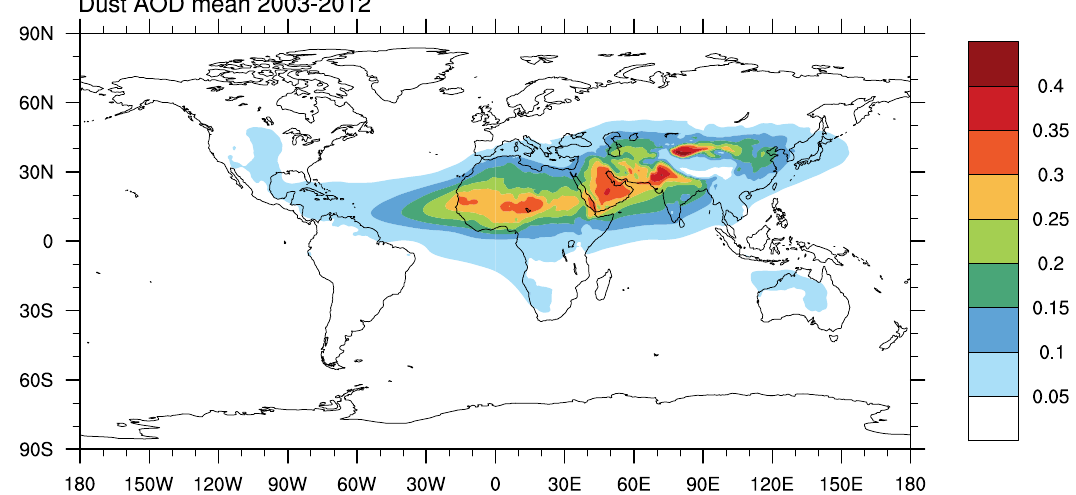
Figure 2. Dust aerosol optical depth (AOD) averaged over the 10-year period 2003-2012. AOD data are taken from the ECMWF MACC reanalysis data set at 6-hourly resolution (0 UTC, 6UTC,12UTC, and 18UTC) and 0.75 ◦ × 0.75 ◦ grid spacing.